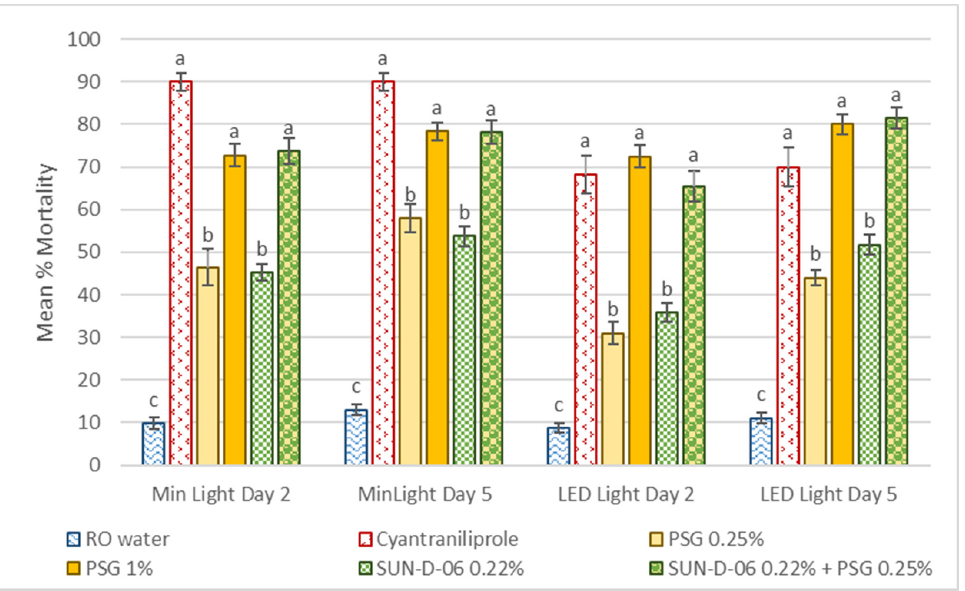
Figure 4. Mean percentage mortality of western flower (WFT) after feeding on treated cabbage leaf discs for two and five days, respectively, in the contact assay. Error bars denote standard error, and bars with the same letters indicate treatments that were not significantly different ( p > 0.05).